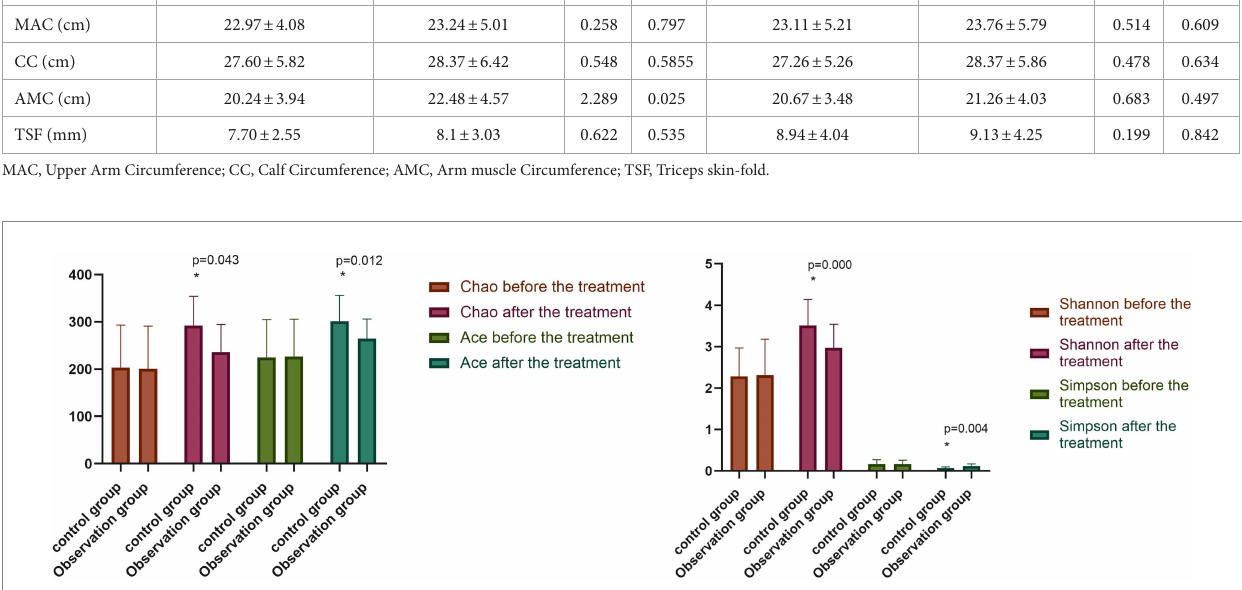
FIGURE 2 Comparison of intestinal flora diversity between two groups before and after the treatment ( − x ± s ). Compared with the control group after the treatment, * p <